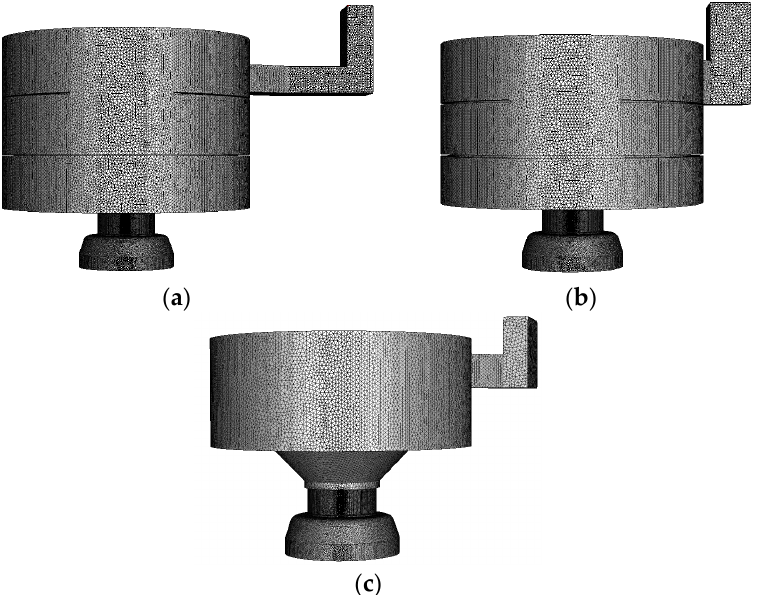
Figure 4. Grids of stove chambers: ( a ) staple food stove A; ( b ) staple food stove B, ( c ) subsidiary